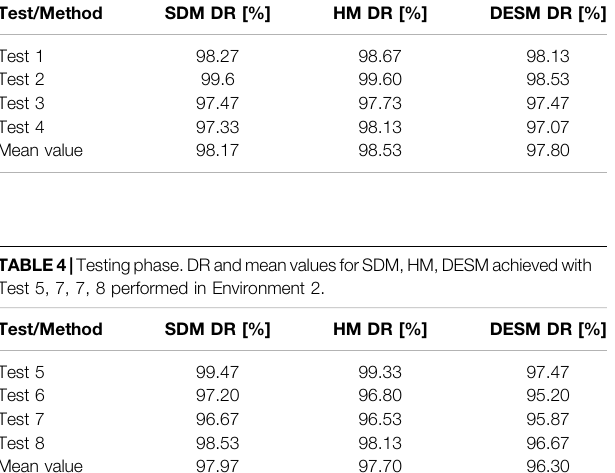
TABLE3| Testingphase.DRandmeanvaluesforSDM,HM,DESMachievedwith Test 1, 2, 3, 4 performed in Environment 1. Test/Method